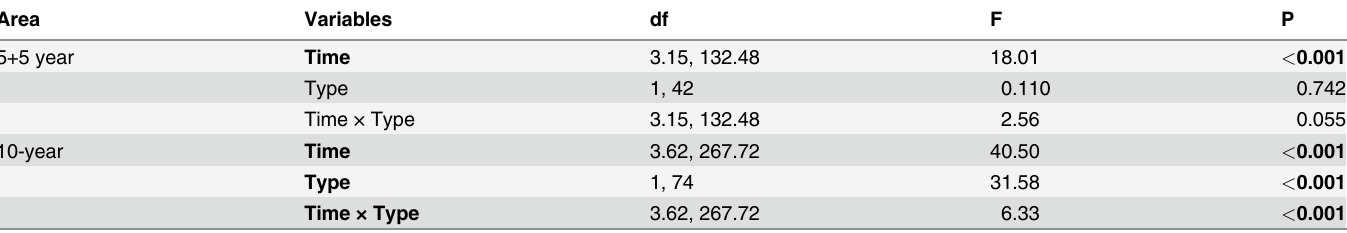
Analyses were conducted for areas fi ve years prior to wolf establishment and fi ve years with presence of wolves, and in areas with continuous wolf presence during ten years.